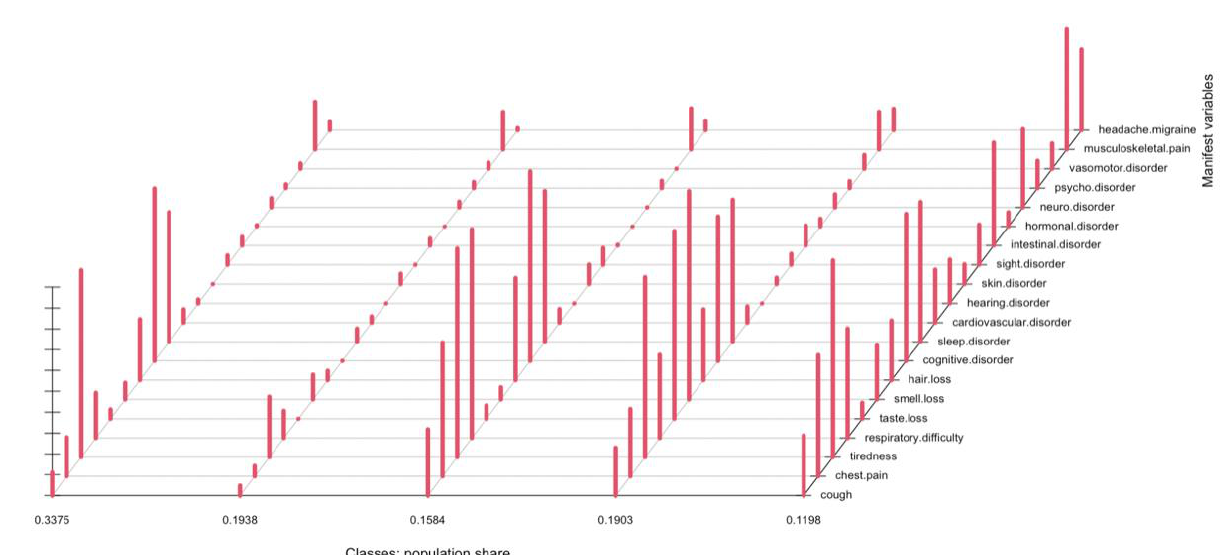
Table 3. Symptom classes in terms of the sociodemographic and clinical characteristics ( N = 506).